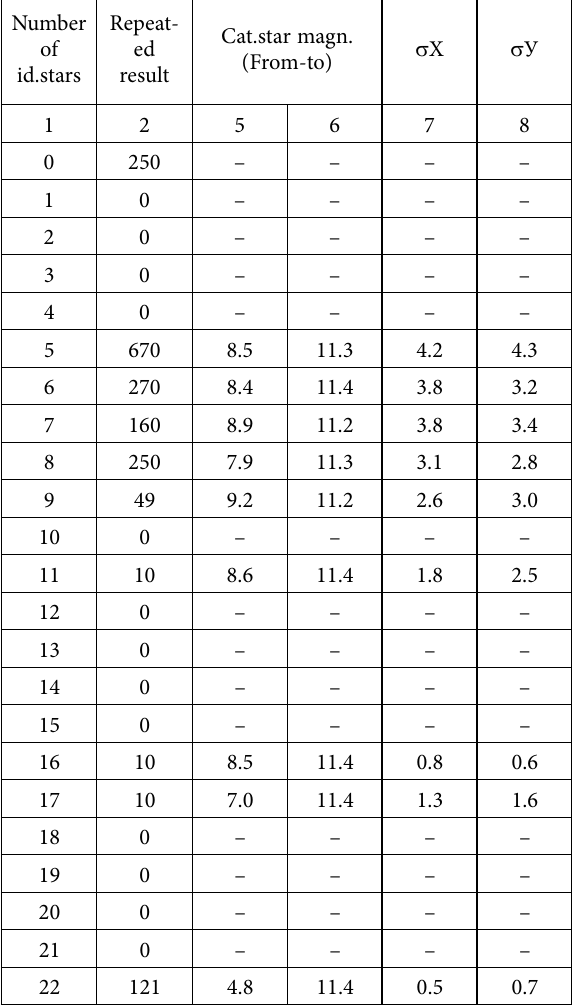
Table 5. Multiple star identification success in frame